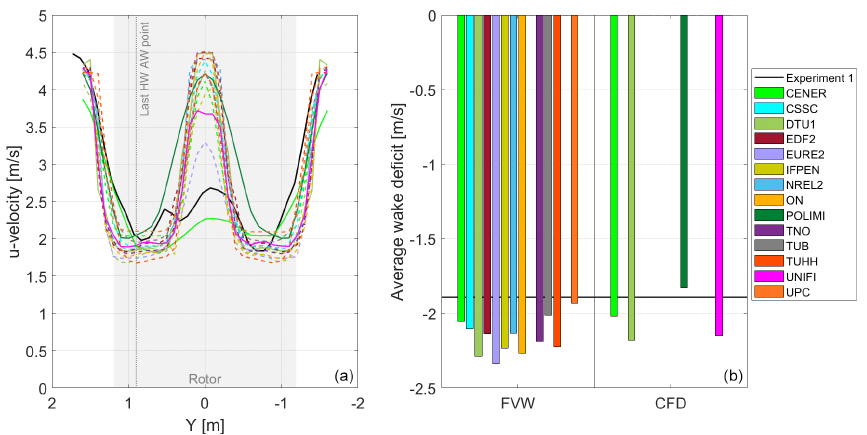
Figure 8. (a) Averaged hot-wire longitudinal velocity for one rotor revolution in the crosswind direction ( x = 5 . 48m, z = hub height) during steady wind conditions. (b) Average wake deficit within the rotor